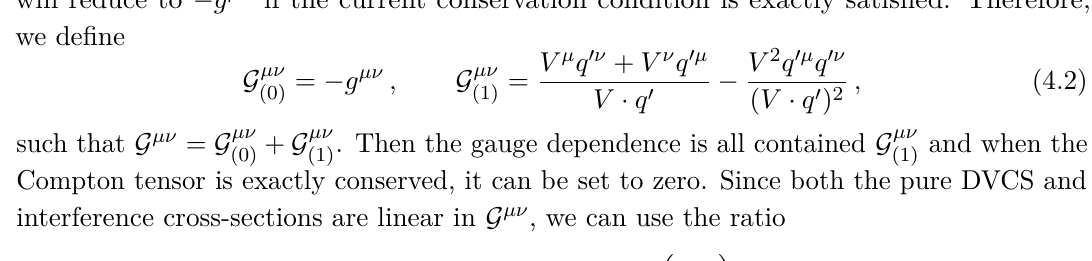
Figure 9 . Comparison of the four-fold interference cross-section d 4 σ UL and β for longitudinally polarized target and unpolarized beam. The gray band consists of all cross-section results with 0 ≤ α ≤ 1 and 0 ≤ β ≤ 2 . The UVa results shown here are obtained by taking α = β = 1 in our set-up and might differ from the actual result in ref. [41].